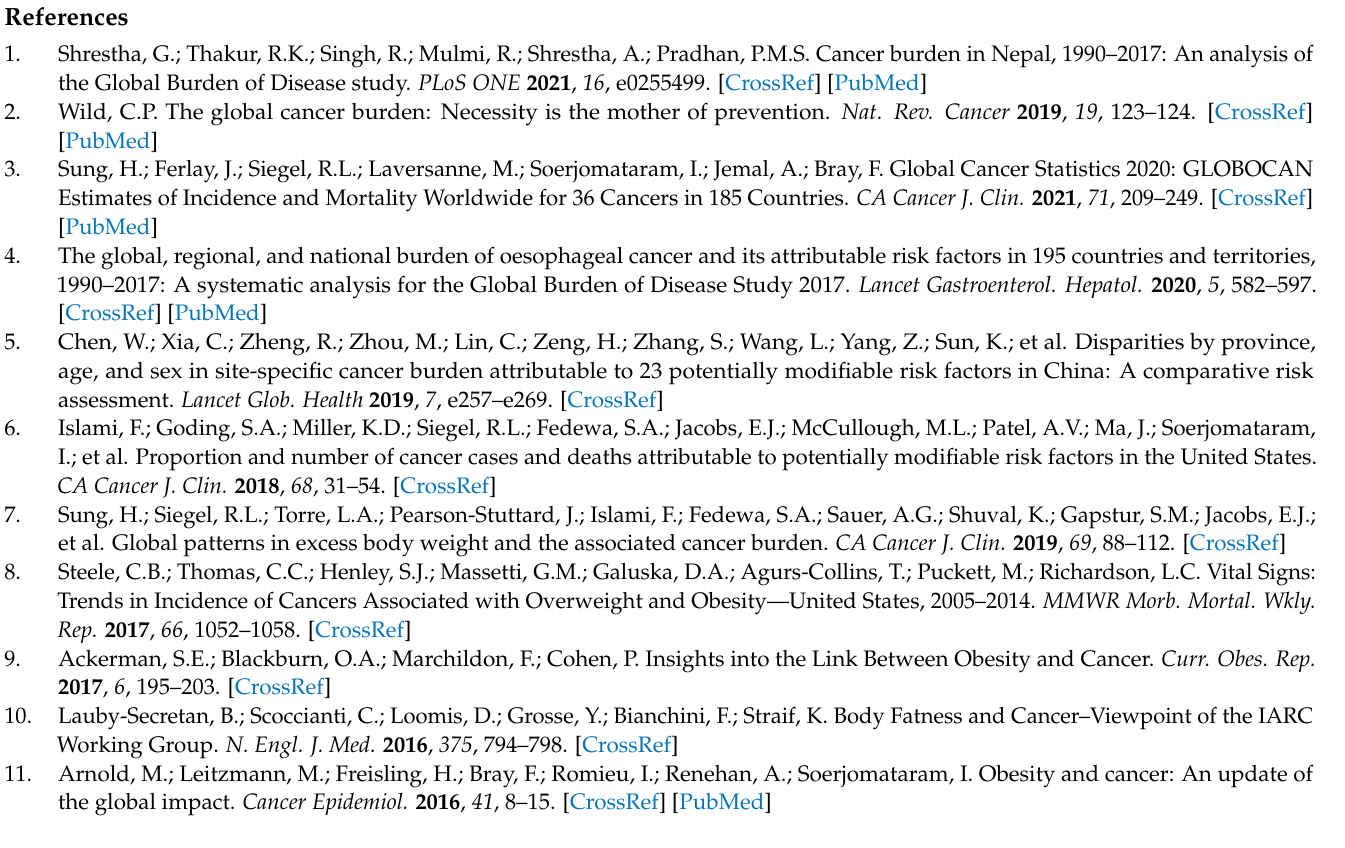
high GWG and the risk of specific cancer in